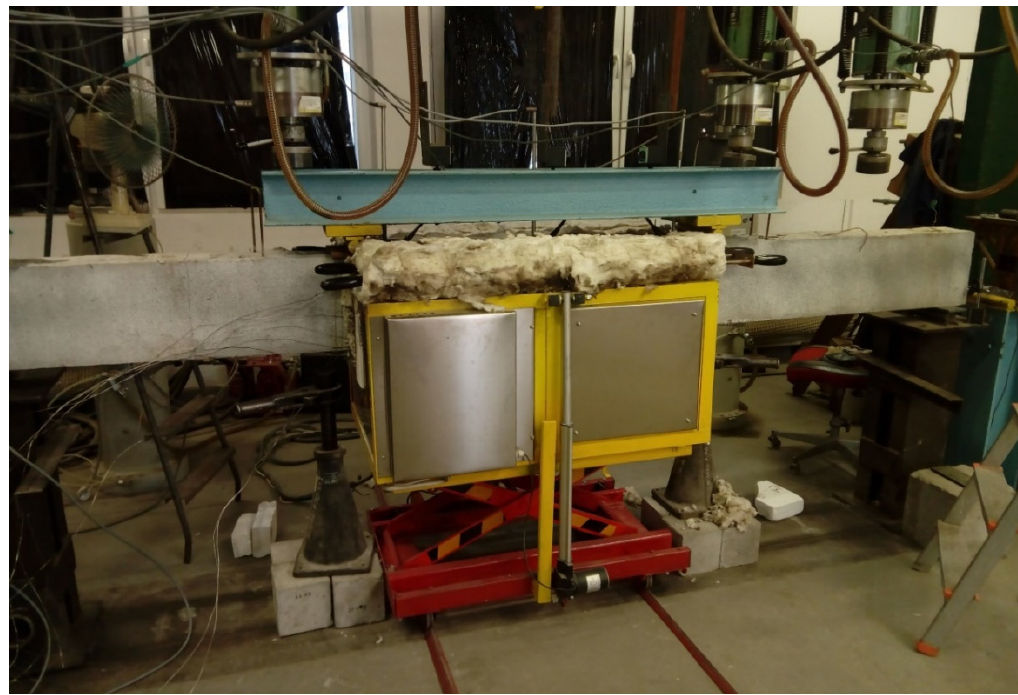
Figure 3. Test setup description.